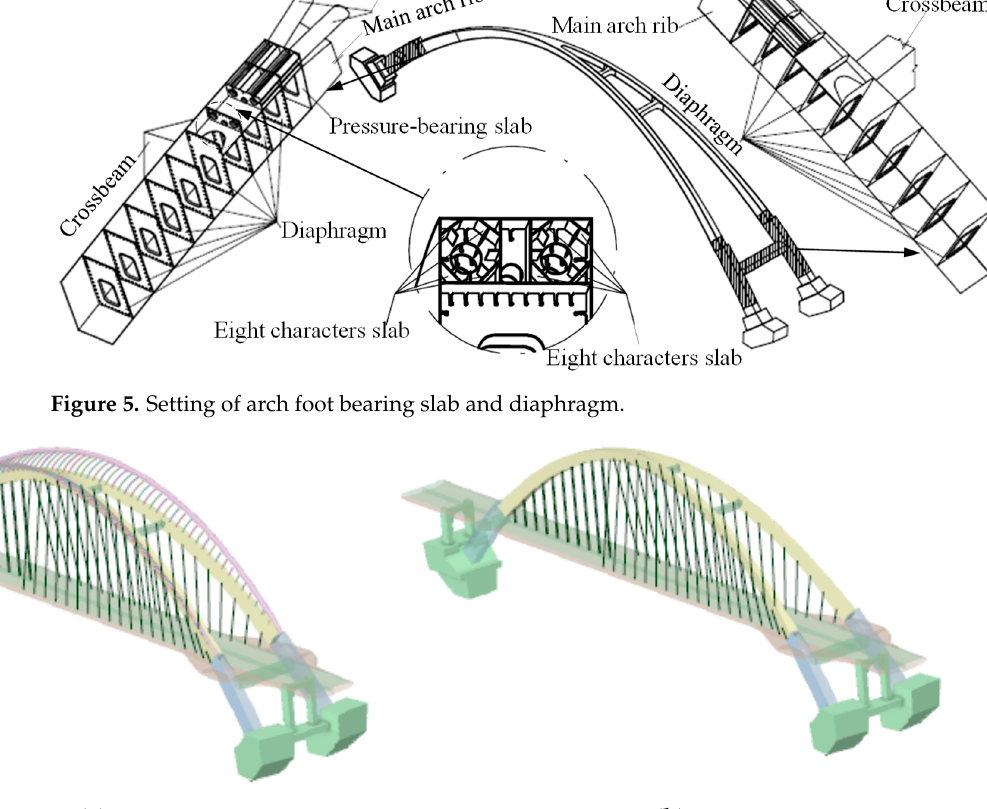
Figure 5. Setting of arch foot bearing slab and diaphragm.